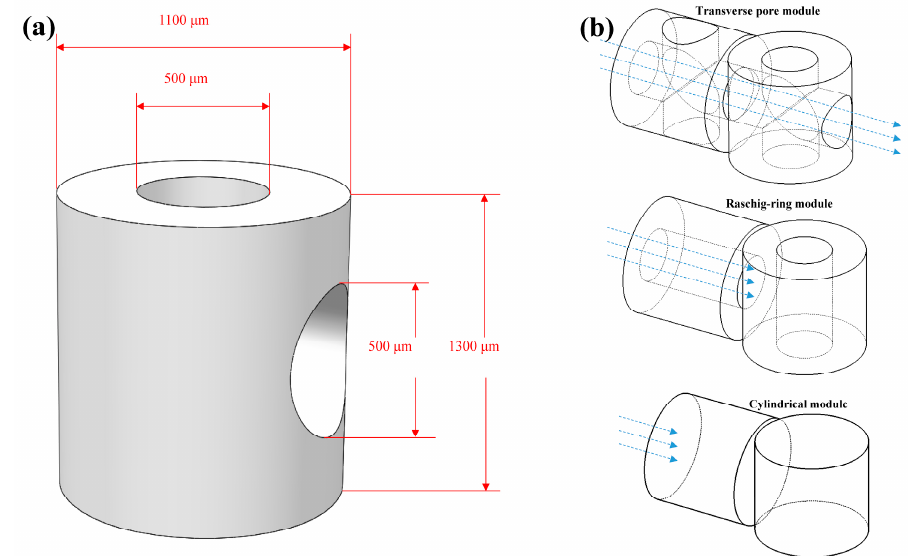
Figure 1. ( a ) Design and dimension of polyglycolic acid (PGA) modules. ( b ) Transverse-pore, Raschig ring, and cylindrical modules under dynamic-flow conditions.